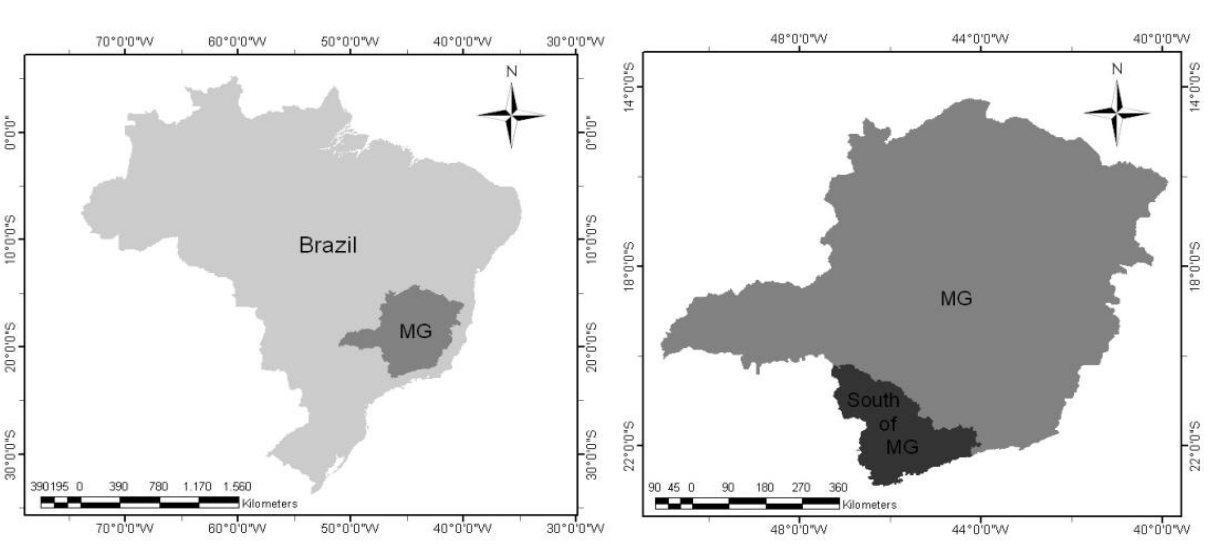
Figure 1. The study area in the south of Minas Gerais State.